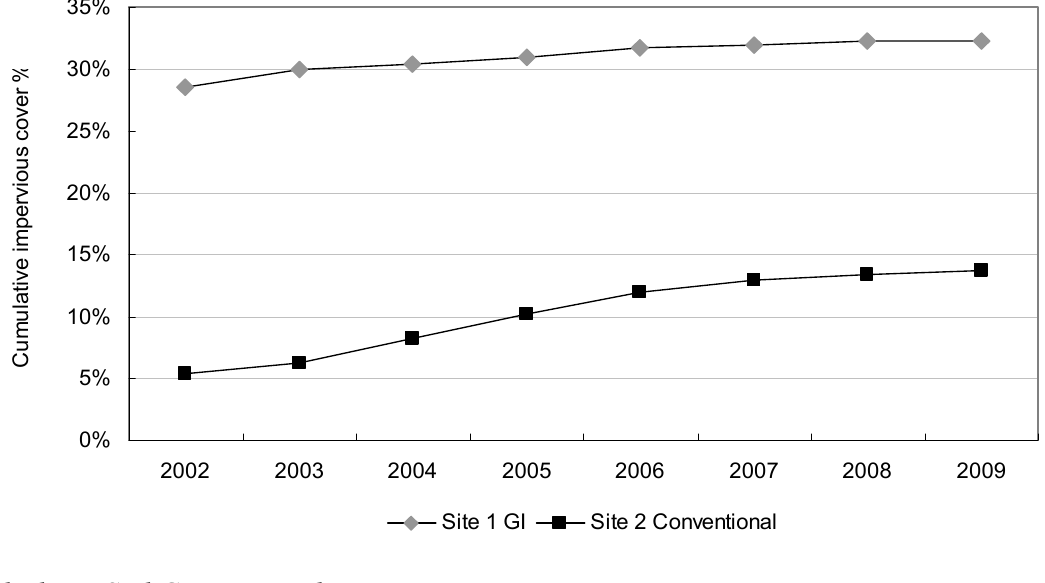
Figure 6. Accumulative percentages of impervious cover area of Site 1 (Panther Creek watershed, The Woodlands green infrastructure development) and Site 2 (Bear Creek watershed, conventional development),